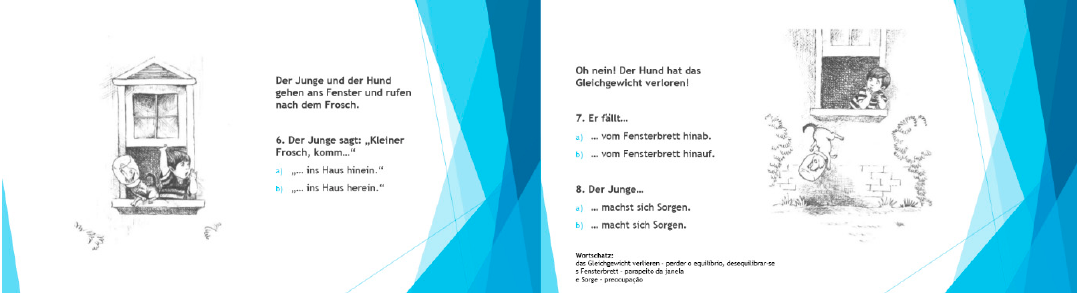
Figure A30. Posttest: Binary-choice recognition task.